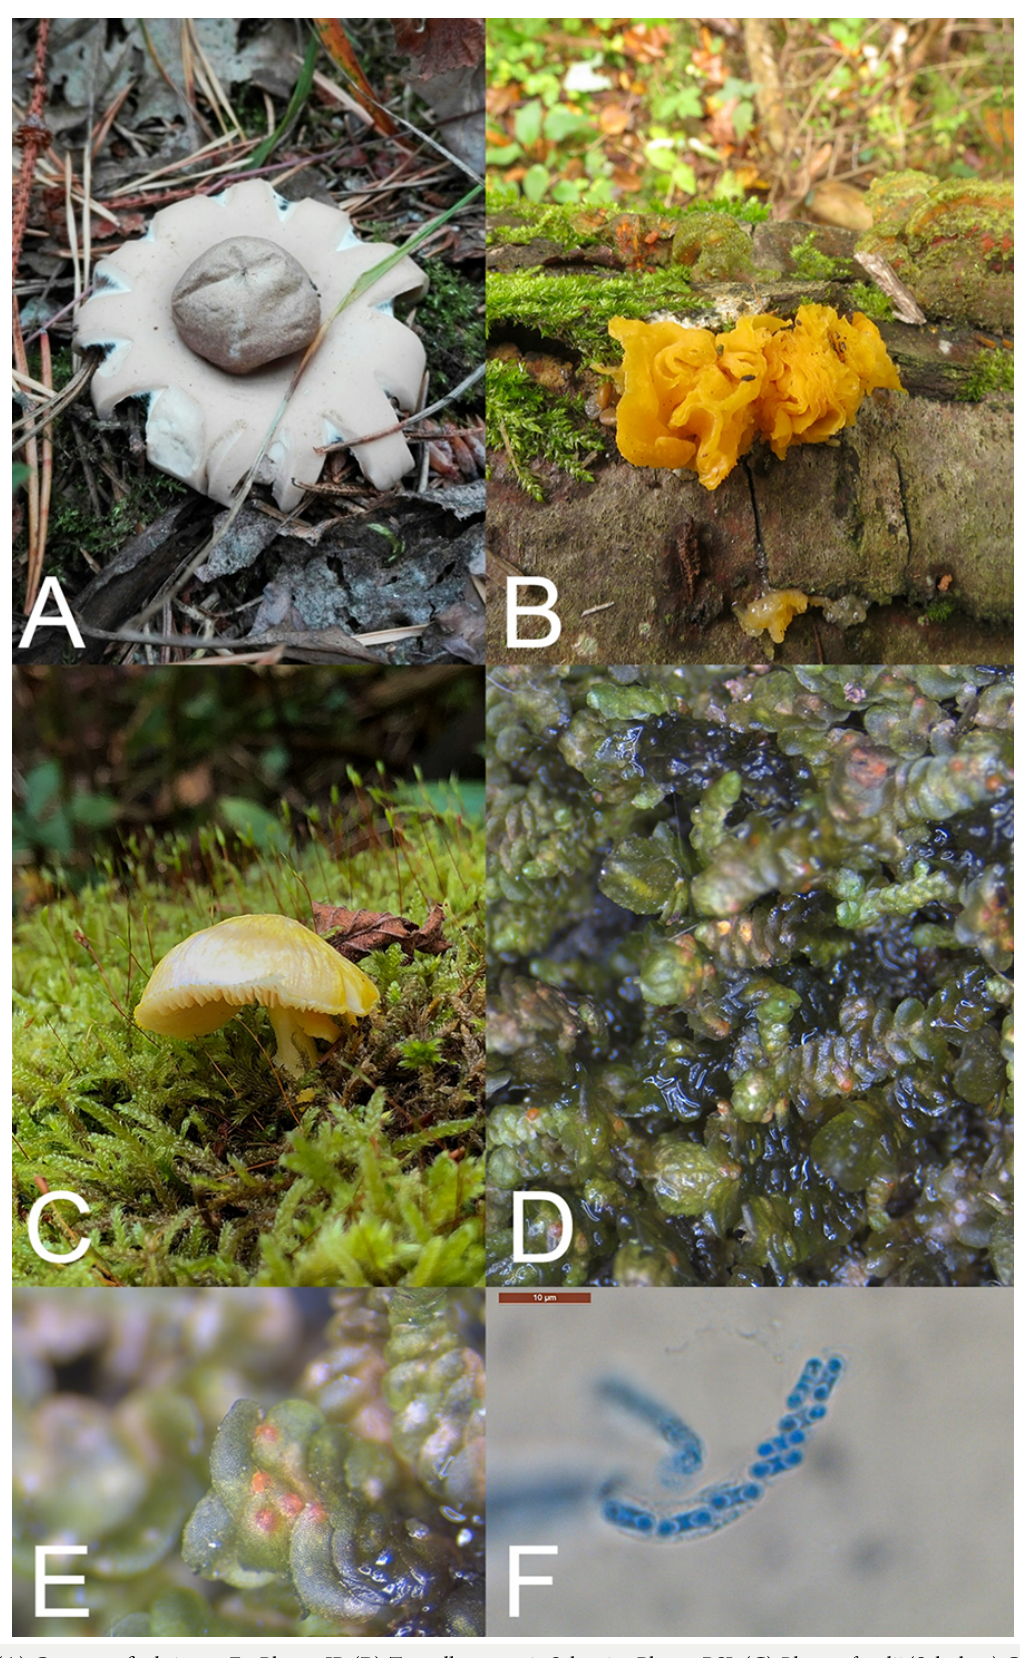
Figure 2 ( A ) Geastrum fimbriatum Fr. Photo: JP. ( B ) Tremella aurantia Schwein. Photo: BSI. ( C ) Pluteus fenzlii (Schulzer) Corriol & P.-A. Moreau. Photo: BSI. ( D–F ) Bryocentria brongniartii (P. Crouan & H. Crouan) Döbbeler. Photo: